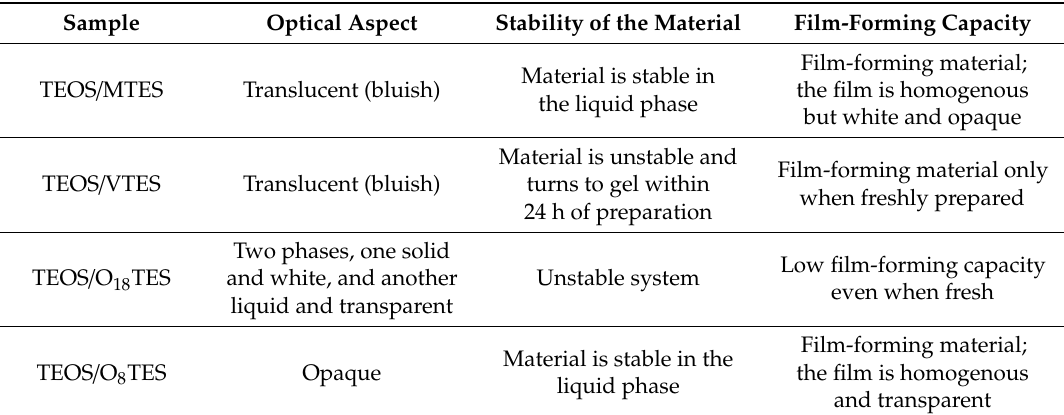
Table 3. Characteristics of the hybrid silica